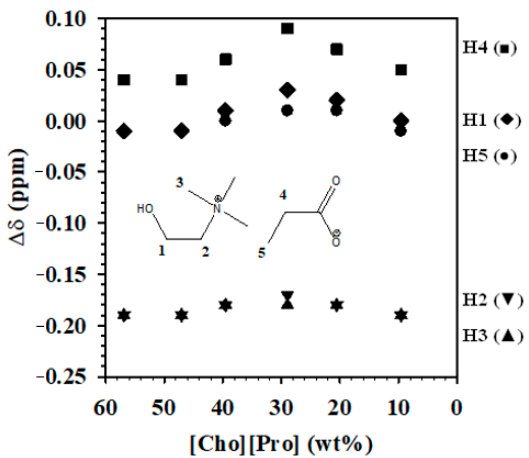
Figure 2. Chemical shift deviation of the protons (H1 ( ◆ ), H2 ( ▼ ), H3 ( ▲ ), H4 ( ■ ), H5 ( ● ) following the numeration indicated in the IL formula overlapped in the figure) in aqueous solutions of [Cho][Pro] compared to pure [Cho][Pro]. Note that the chemical shifts of H2 and H3 overlap.